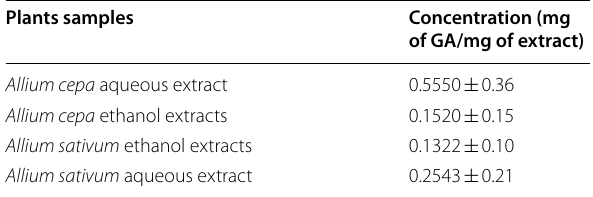
Table 1 Total phenolic content of A. cepa ( onions) and A. sativum